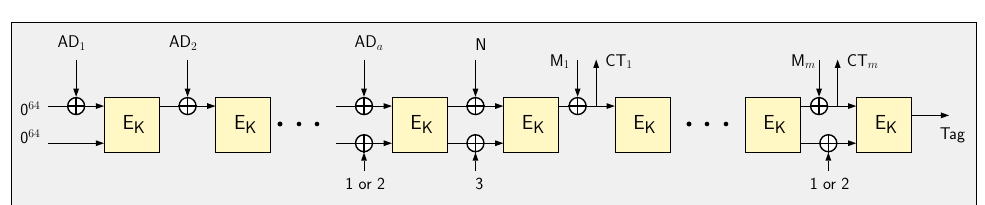
Figure 10: The high-level overview of SAEAES , which depicts the processing of m message and a associated data